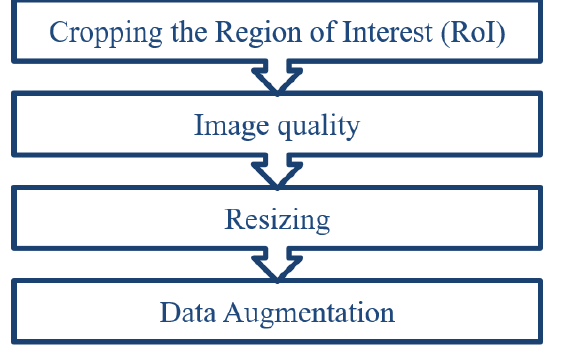
Figure 1. Preprocessing